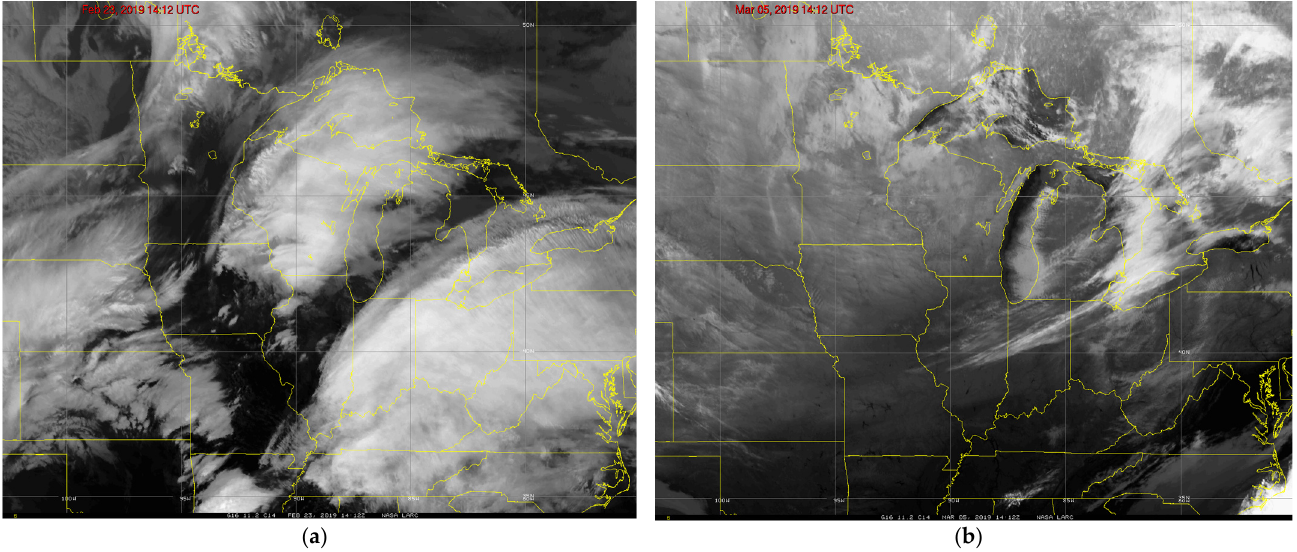
Figure 4. ( a , b ) Wind rose plots (top), ( c , d ) hydrometeor size distributions—pdf (bottom), ( e ) P-T profiles measured in flight (right) for two selected flights, F20 and F28. 2.2.1. Flight 20, 23 February 2019 On the morning of 23 February 2019, a strong area of low pressure over the Texas Panhandle area was lifting north-eastward into Kansas, encroaching into the western side of an area of high pressure centered over New England. The advancement of the precipi- tation into southern Wisconsin led to the development of a deep layer dominated by ice crystals falling into a melting layer, then subsequently, into the near-surface sub-freezing layer to form classical freezing rain (FZRA) there during the morning hours [38]. These environments and the classical FZRA mechanism were the focus of this day’s mission.